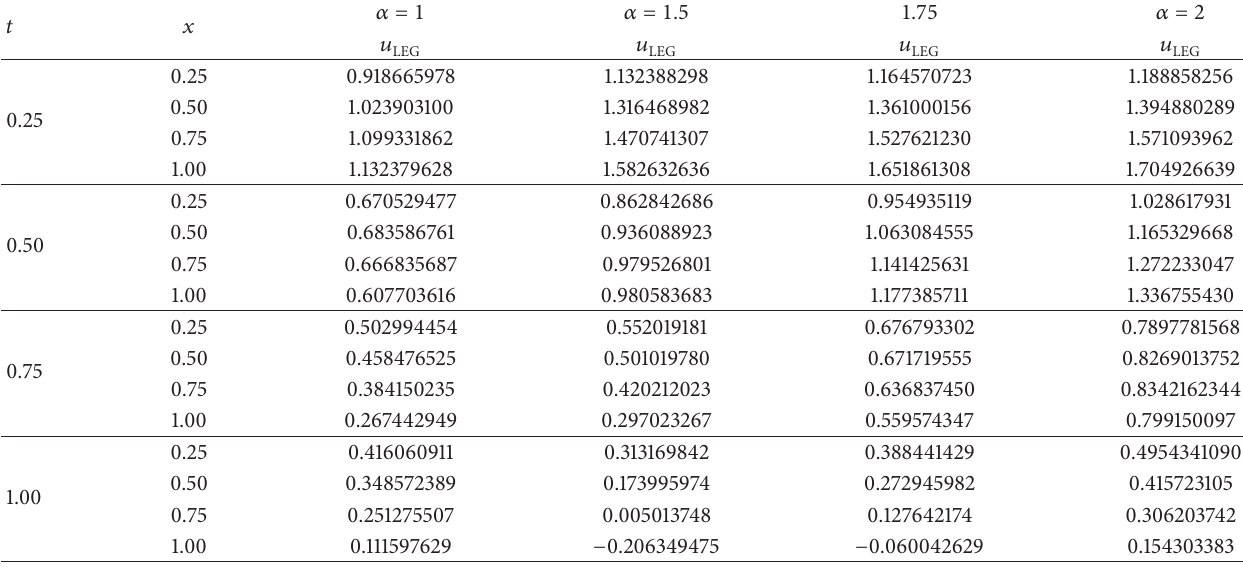
Table 2: Approximate solutions for Example